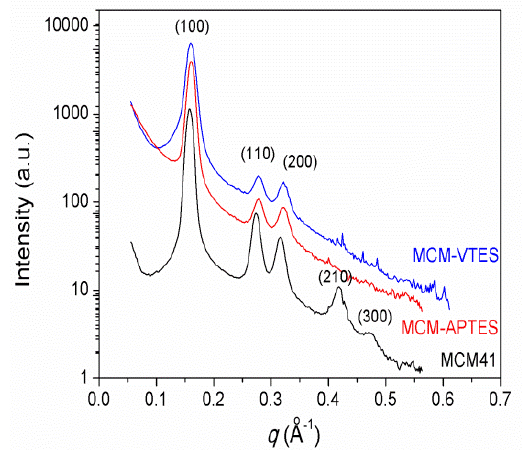
Figure 2. SAXS analysis of MCM-41-type